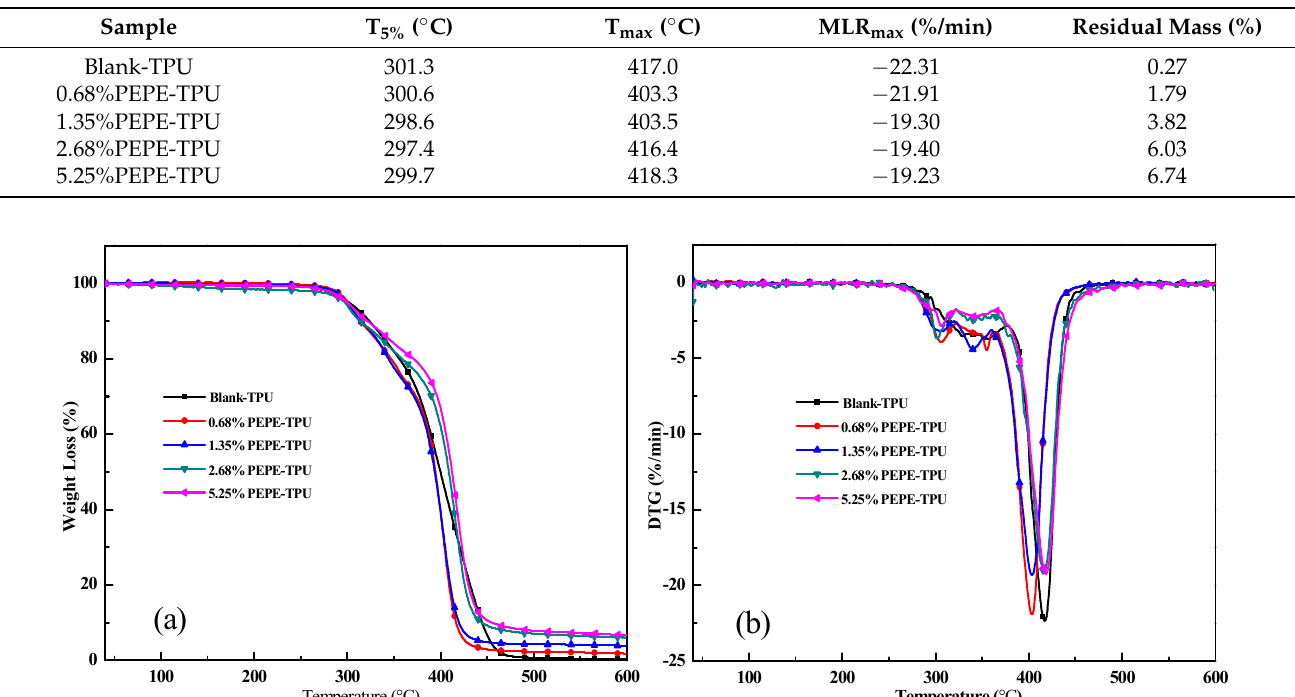
Table 3. TG data of flame-retardant TPU with PEPE.